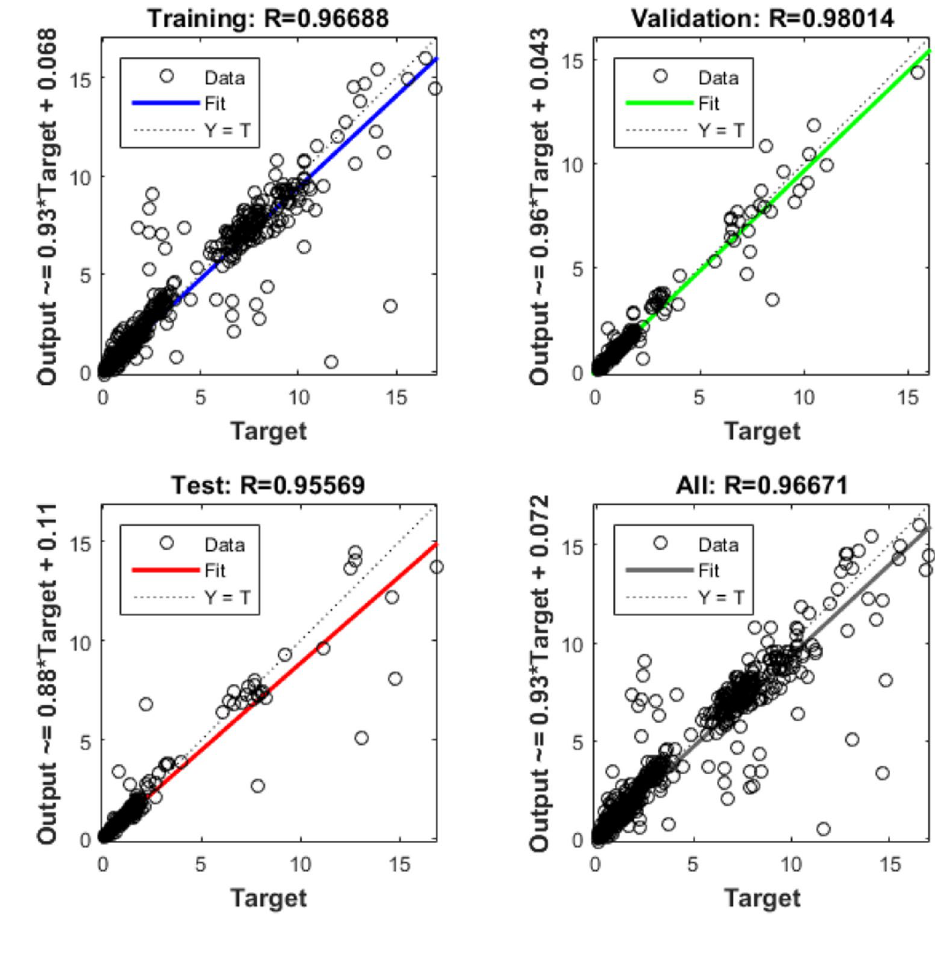
Fig. 12 MATLAB model vali- dation of Field X